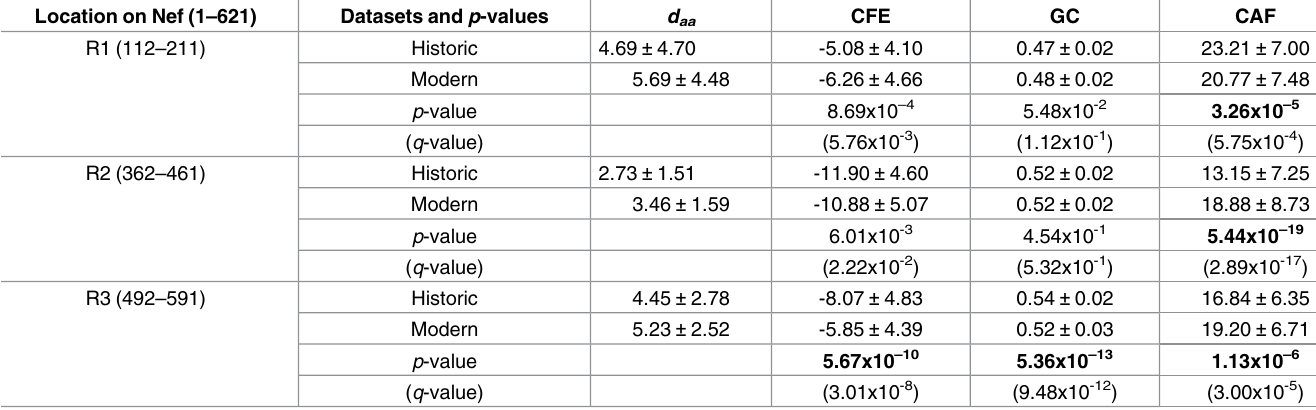
Table 2. Summary of Nef regions with the most significant change in CAF.